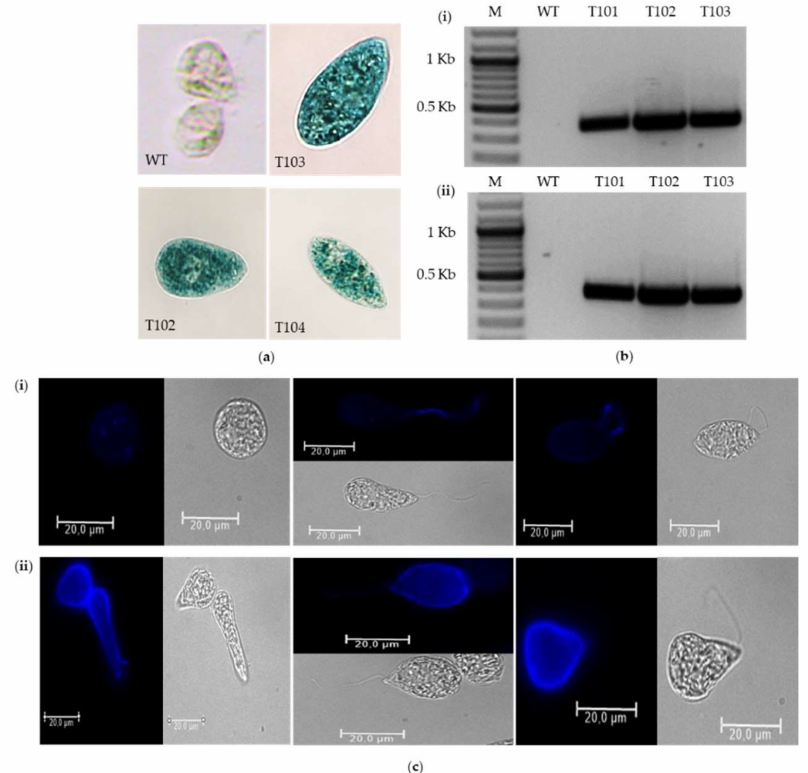
Figure 5. Analysis of transgene integration and expression in E. gracilis . ( a ) GUS histochemical assay of E. gracilis cells transformed with pWEN 650. Wildtype and hygromycin-resistant cells were treated with a substrate for β -glucuronidase, destained, and observed at a magnification of 400 × for GUS expression. Transformed E. gracilis cells hosting the hptII-2A-gus gene stained blue (T101–T103) due to the activity of GUS, while blue color is absent in control E. gracilis cells (WT). ( b ) PCR-based confirmation for the transformation of pWEN 650 into E. gracilis . PCR analysis with hptII gene- specific primers (HptII-1841-For and HptII-1842-Rev) and gus gene-specific primers (GUS-1849-For and GUS-1850-Rev) yielded expected amplicons of 359 bp ( i ) and 377 bp ( ii ), respectively, only in transformants (T101–T103) and not in control wildtype E. gracilis cells (WT). The lane label M stands for size markers. ( c ) Indirect immunofluorescence assay of wildtype cells and transformants with the anti-GUS antibody. Wildtype E. gracilis cells ( i ) and E. gracilis cells transformed with the binary vector pWEN 650 ( ii ). Scale bar = 20 µ